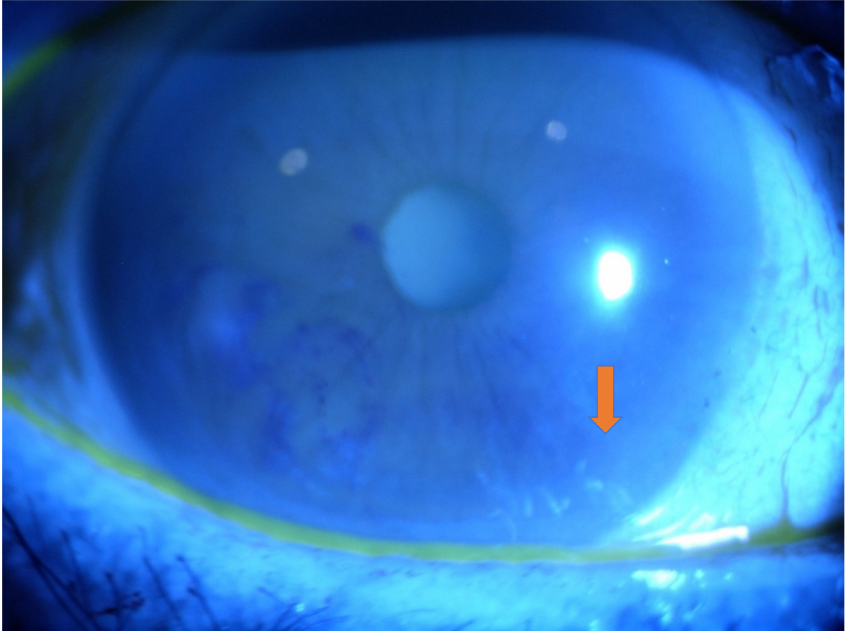
Figure 7. Slit-lamp examination showing areas with altered fluorescein distribution (BUT < 10 sec) and localized fluorescein staining (arrow) in amyloidosis patients (magnification 10 × and diffuse